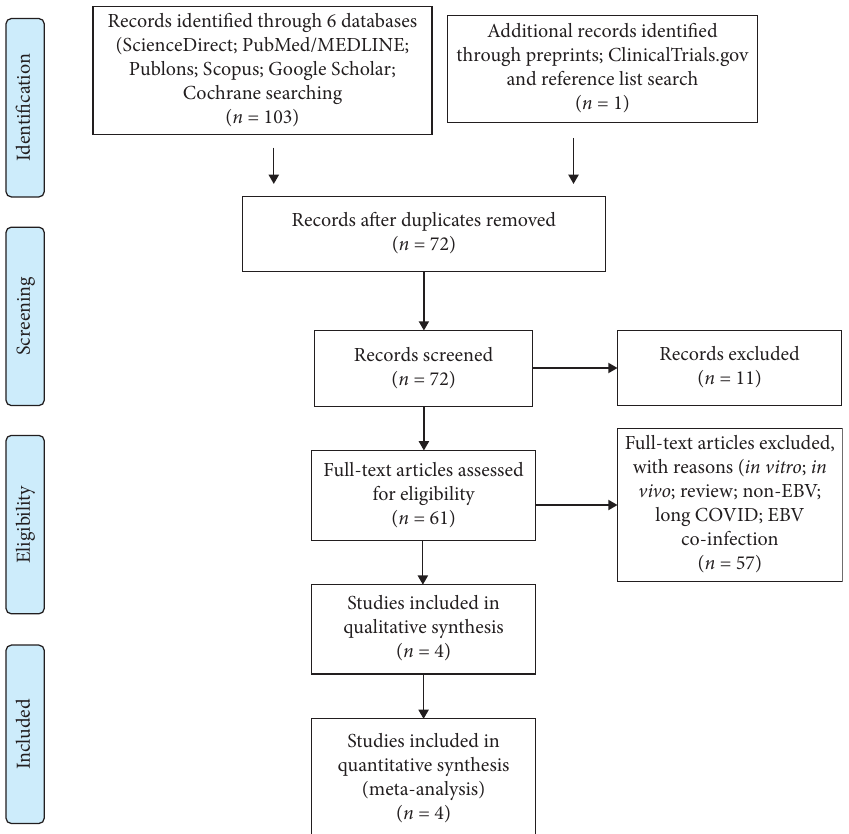
Figure 1: Te PRISMA fowchart illustrating the systematic inclusion and exclusion process for the literature search related to EBV reactivation in COVID-19